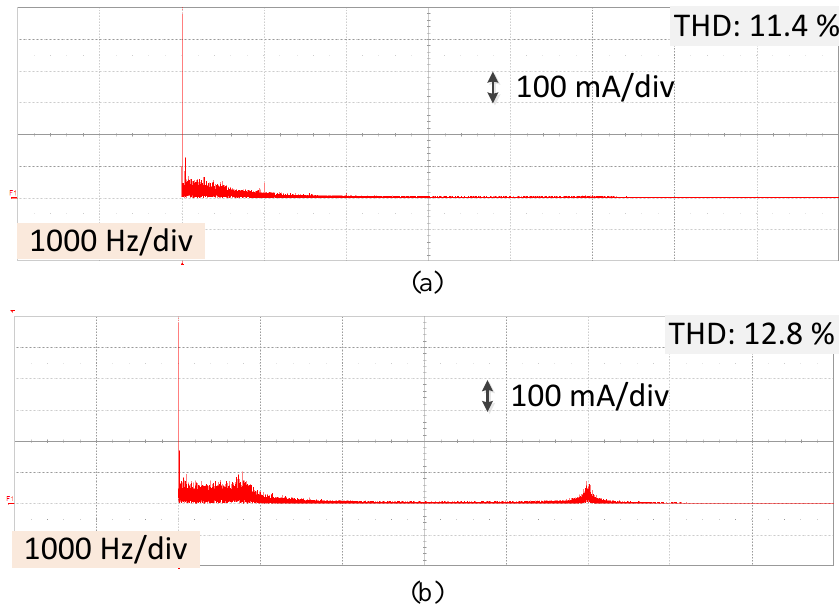
Figure 9. Experimental frequency spectra of A-phase motor current at 100 rpm. ( a ) MSPTC, ( b ) UFCS-PTC.